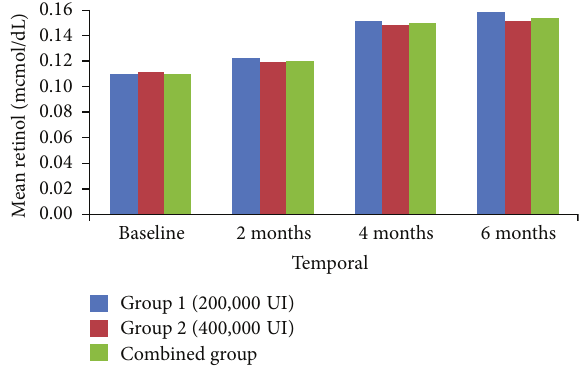
Figure 2: Mean retinol, by treatment group and duration of fol-